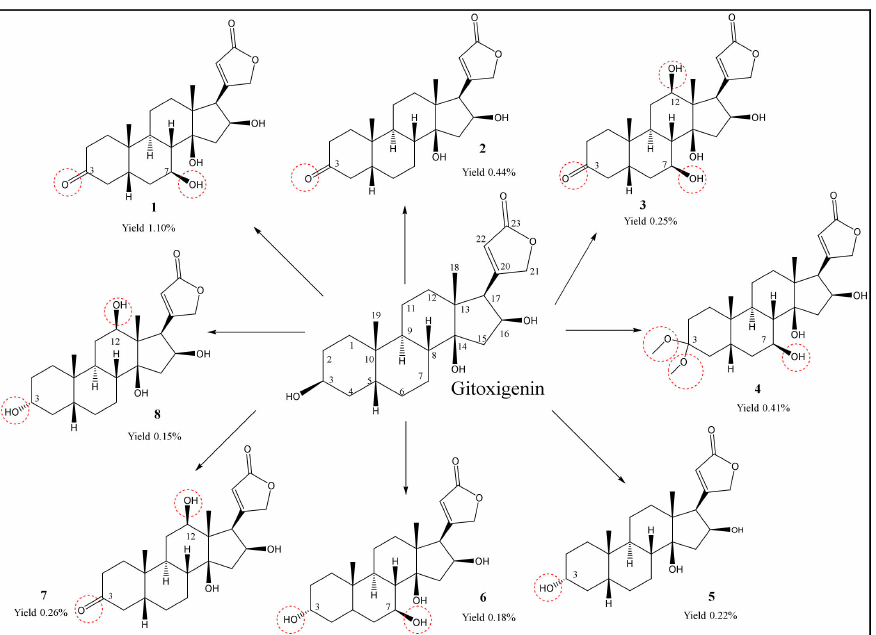
Figure 5. Structures and yields of the metabolites obtained via microbial biotransformation of gitoxigenin by A. eureka